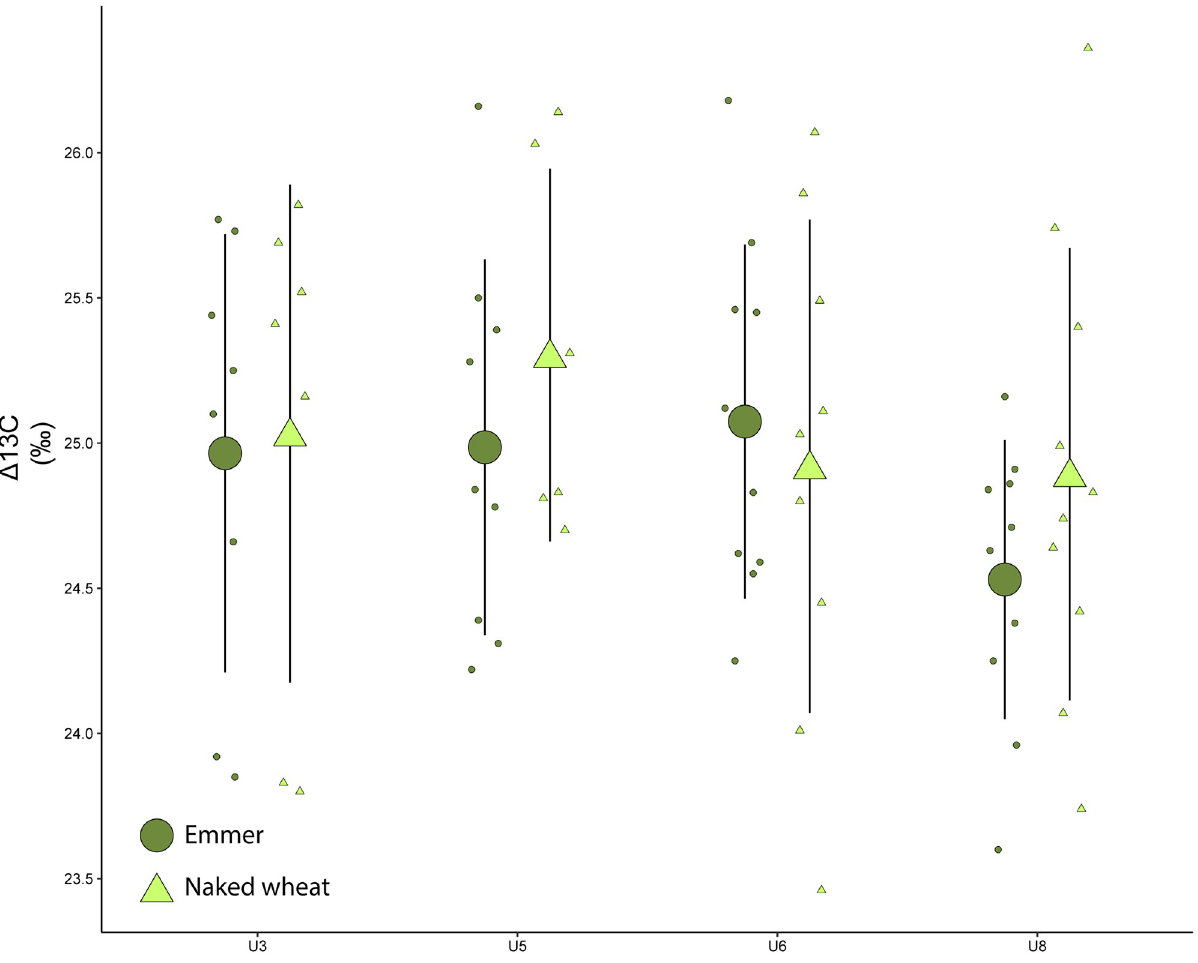
Fig 19. Δ 13 C values of emmer and naked wheat from units 3, 5, 6 and 8 of Zug-Riedmatt according to crop types. The higher Δ 13 C values suggest greater water availability.